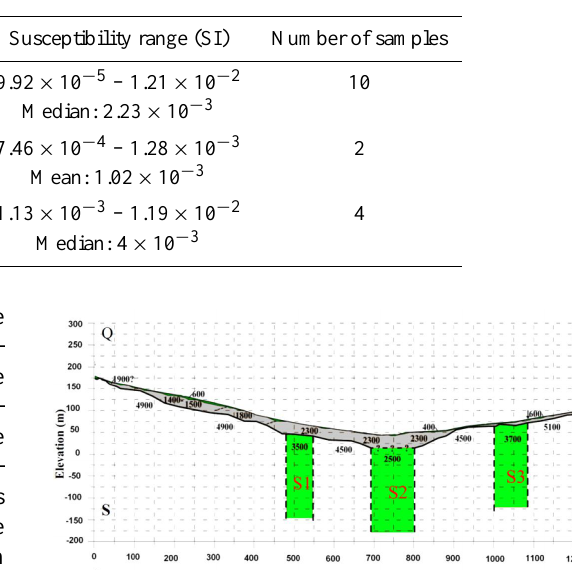
Table 1. Summary of the physical properties of the rock samples. Details of the petrophysical analysis and sample information are given in Biedermann (2010).